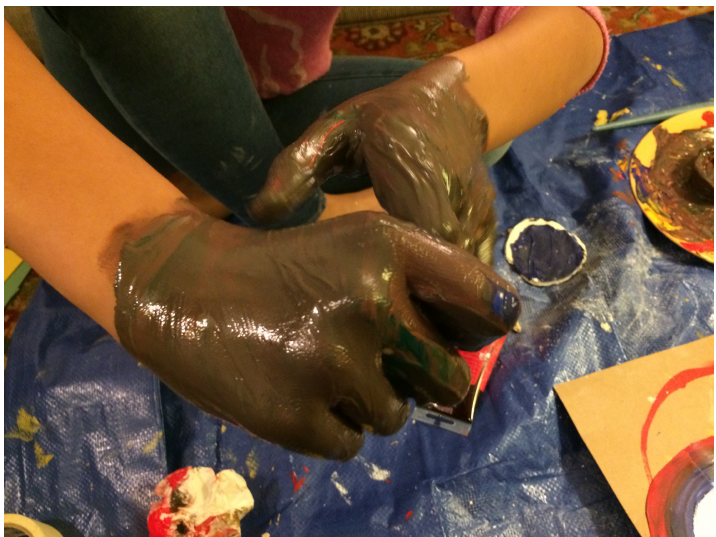
Figure 3Figure 3. Making and experiencing the mess/Can I be loved. Tempera paints. With time, more conversation about intentionality and meaning coincided with the mixing of paint. Elizabeth began to explore the colors she was creating and often matched them with her skin tone. As a darker-skinned person adopted by lighter-skinned parents, she seemed to focus on the meaning of exploring different browns. She would often mix all the colors to create brown, then ask me whether it looked like dirt or feces, was it too messy, and could I see it had all the colors inside it still? As a lighter-skinned